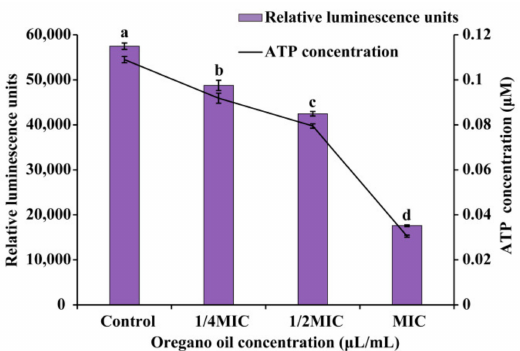
Figure 4. Effects of OEO on intracellular adenosine triphosphate (ATP) of E. faecalis . Different lowercase letters indicate statistically significant differences between the means ( p <